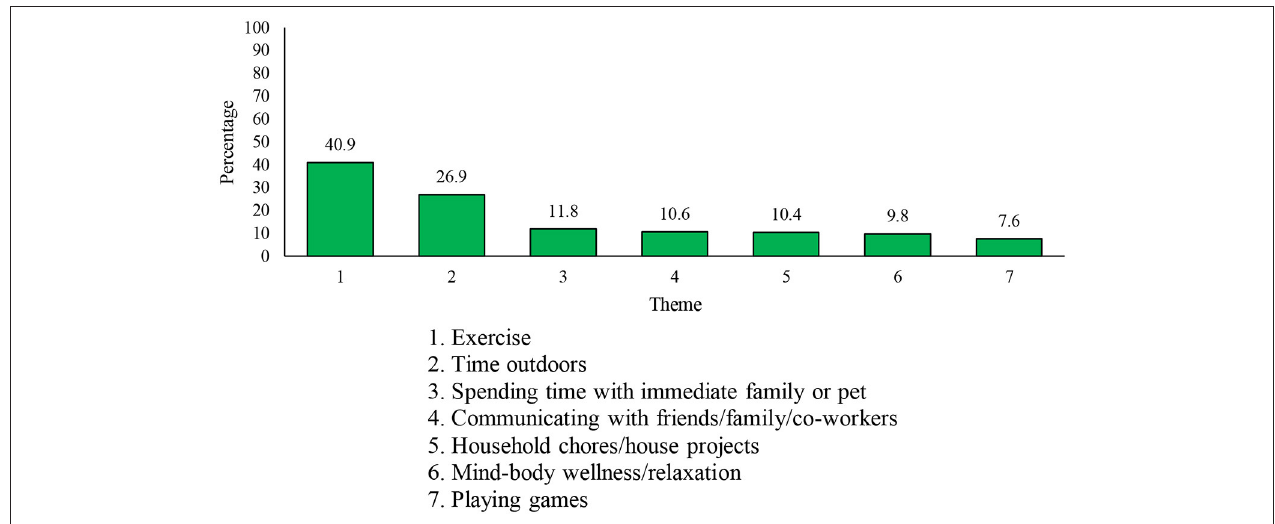
FIGURE 5 | Seven most frequently mentioned stress management strategies.